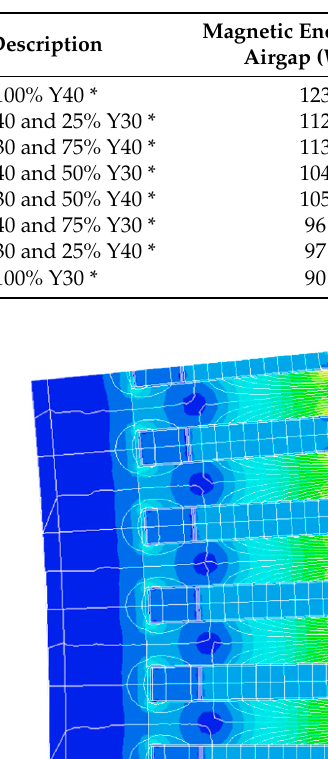
Table 5. Amount of the different ferrites in the generator and the resulting magnetic energy in the airgap, relative cost and relative magnetic cost for the different cases. Star * indicates the magnet closest to the stator.